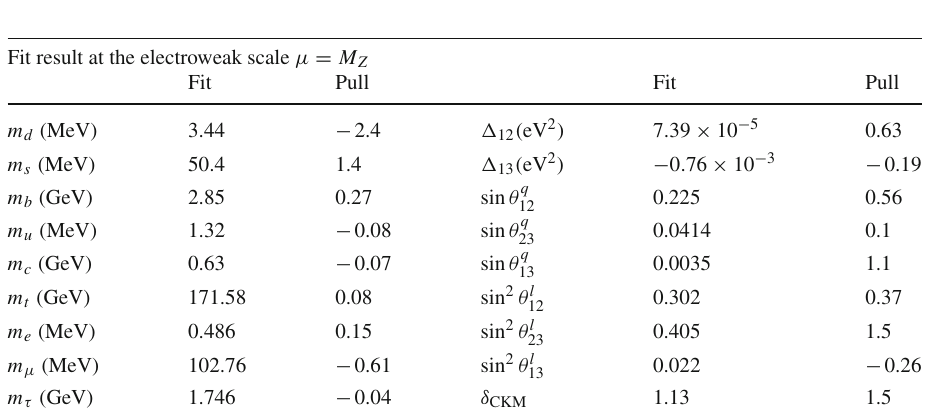
Table 2 Result of the fitting procedure, as described in the text. The pull of a fit value O fit